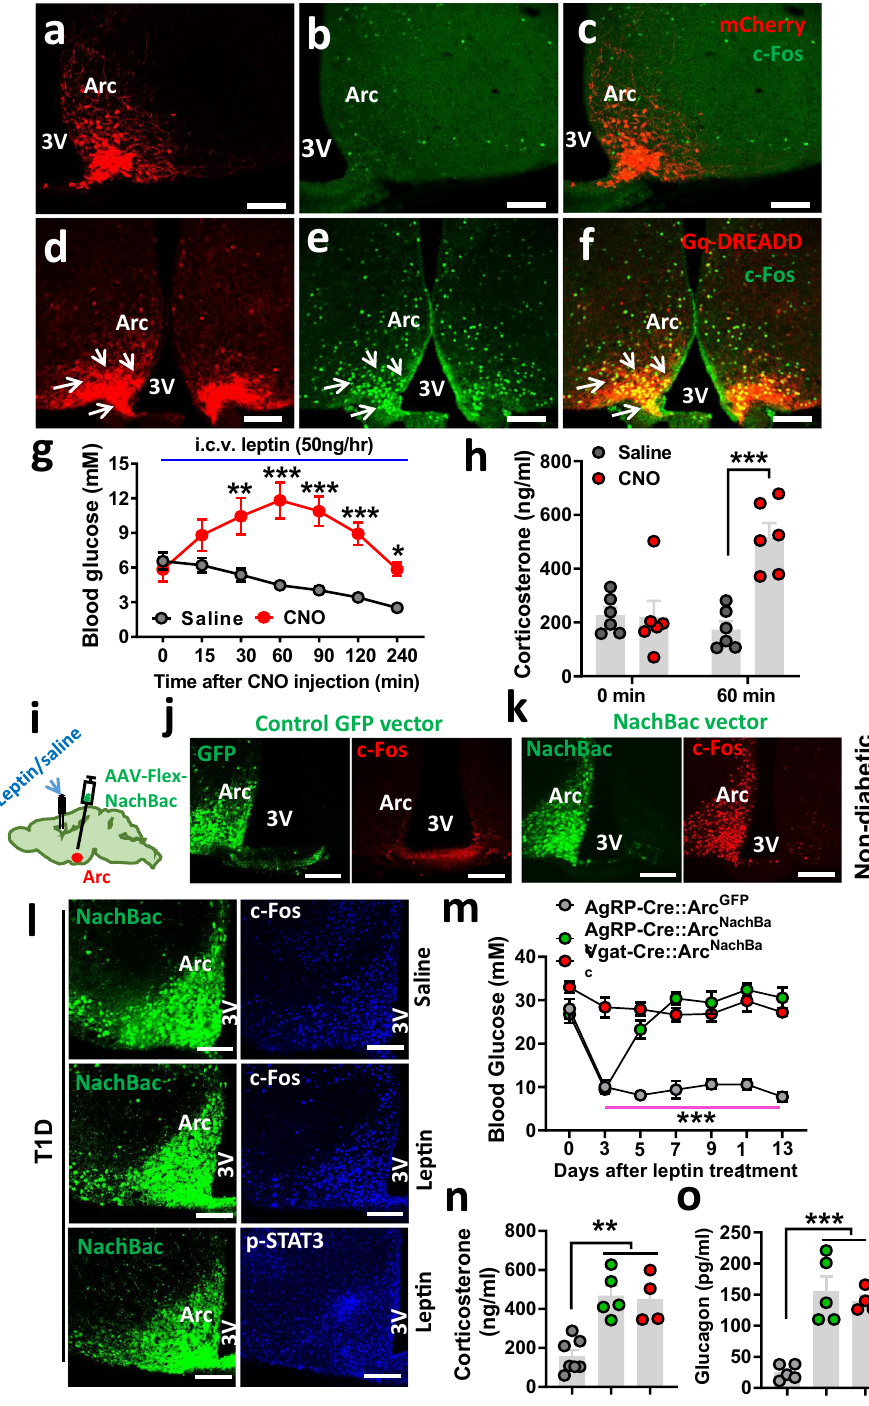
activation. We fi rst examined whether acute activation of Arc to falling glucose levels in controls (Fig. 2g). This glucose- LepR neurons reverses the leptin action. Toward this, we ste- increasing effect lasted for nearly 4 h, within the range of duration reotaxically delivered control vectors (Fig. 2a) or AAV-Flex- in CNO-induced activation of DREADD receptors. CNO-induced hM3D(Gq)-mCherry vectors (Gq-DREADD) (Fig. 2d) bilaterally glucose increase was accompanied by increased corticosterone to the Arc of LepR-Cre mice. Selective viral targeting was veri fi ed (cort) levels (Fig. 2h), an opposite response to leptin treatment by mCherry expression (Fig. 2a, d), and the function of Gq- effects in T1D. To rule out a potential nonspeci fi c effect of CNO DREADD was veri fi ed by CNO-induced c-Fos speci fi cally in Arc in the observed glucose-increasing effects, we generated a new LepR neurons (Fig. 2b, c, e, f). These mice were fi rst made T1D group of STZ-T1D mice with glucose normalized by i.c.v. leptin and i.c.v.-treated with leptin, and then these glucose-normalized treatment (Supplementary Fig. 3a), and found that CNO injec- mice were divided in two groups, one treated with saline and the tions had no effect on the glucose level in these mice (Supple- other with i.p. CNO. CNO effectively increased glucose compared mentary Fig. 3b). Thus, acute activation of Arc LepR neurons is NATURE COMMUNICATIONS| (2021) 12:2662